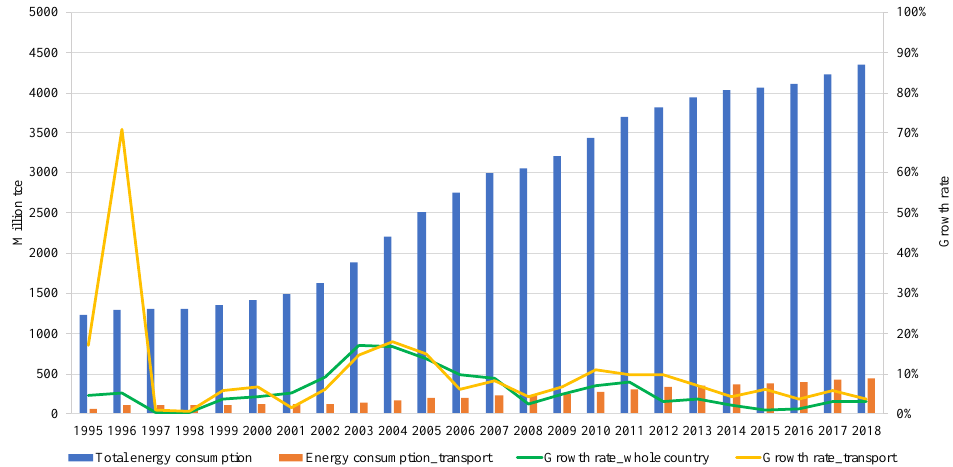
Figure 1. Energy consumption in China. Source: calculated based on China Energy Statistical Year- books.